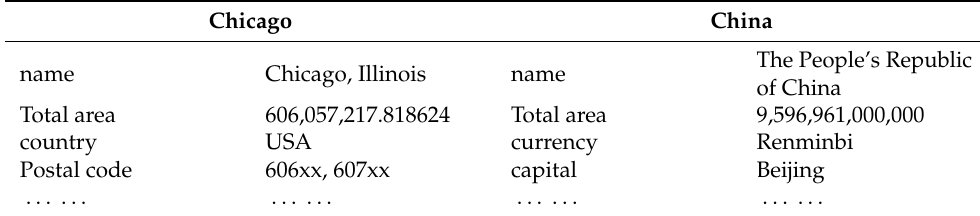
Table 2. Example of attribute comparison for two geo-entities.